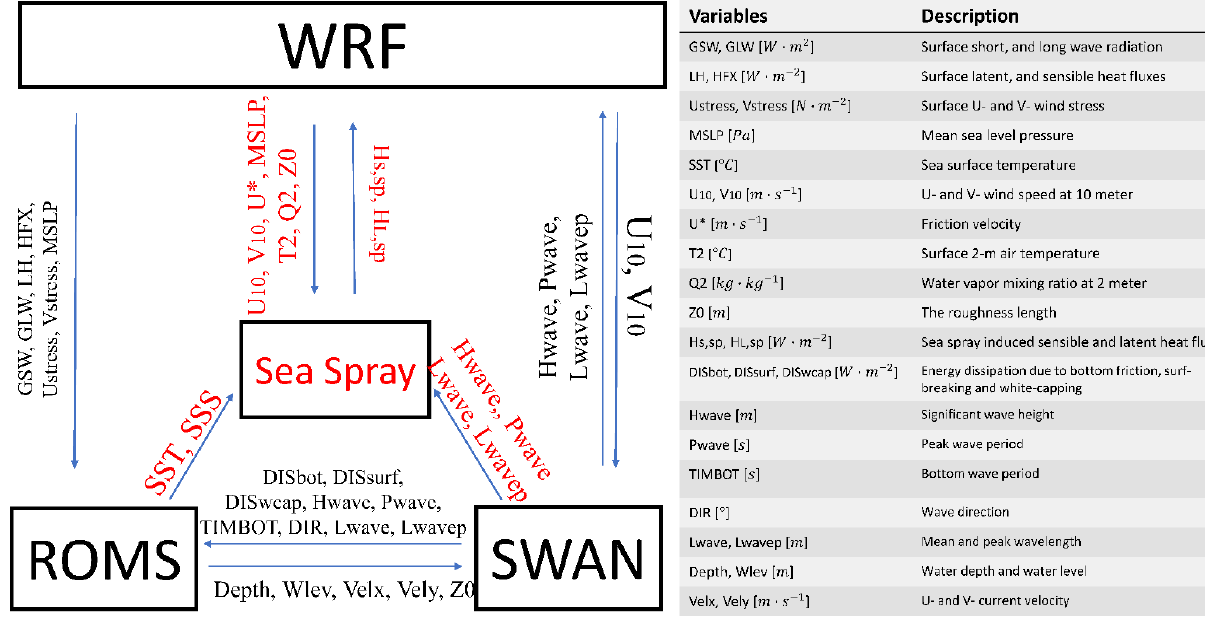
Figure 1. Schematic illustration of the numerical model used in this study (modified after Warner, Armstrong, He and Zambon [21]. 𝐻 𝐿,𝑠𝑝 and 𝐻 𝑆,𝑠𝑝 are the net latent and sensible heat fluxes induced by the sea spray, respectively (see Equations (6) and (7)). For other coupling parameters exchanged between each of the components, please refer to Warner, Armstrong, He and Zambon [21].